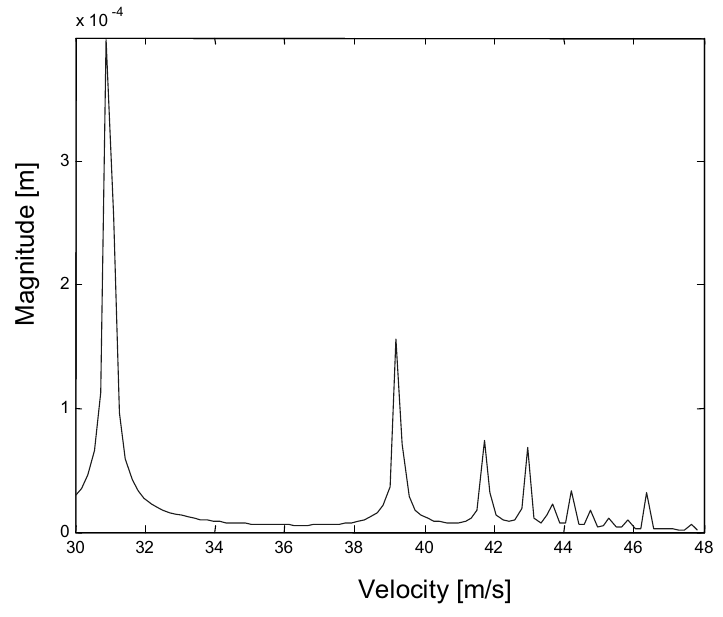
Fig. 14. Magnitude of the response for different rotating force tangential velocities with P int = 120 bar. derived from the real tire. This can be easily done, however, by statically deforming the real tire or an FE detailed model of it and computing and equivalent bending